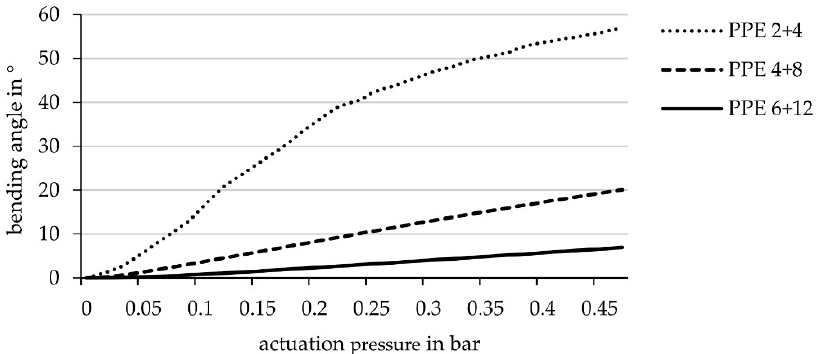
Figure 9. Achievable bending angle (simulation) in relation to the actuation pressure for laminate set-ups with different stiffness’s: 2 + 4 layers ET222 (laminate set-up of PPE 2 + 4 similar to Figure 2), 4 + 8 layers ET222 and 6 + 12 layers ET222, hinge width 10 cm.